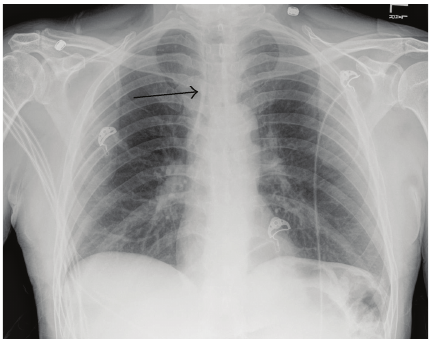
Figure 1: Anterior-posterior chest X-ray demonstrating tracheal wall thickening (arrow) as the result of alkaline